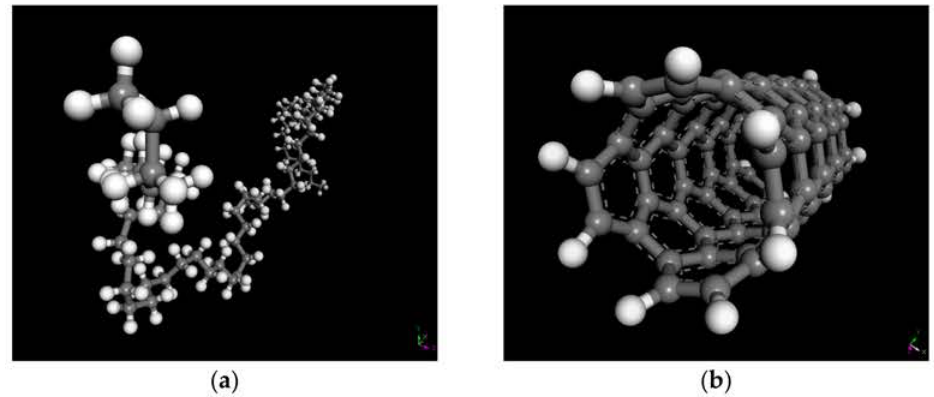
Figure 3. Molecular models of PE ( a ) and CNT ( b